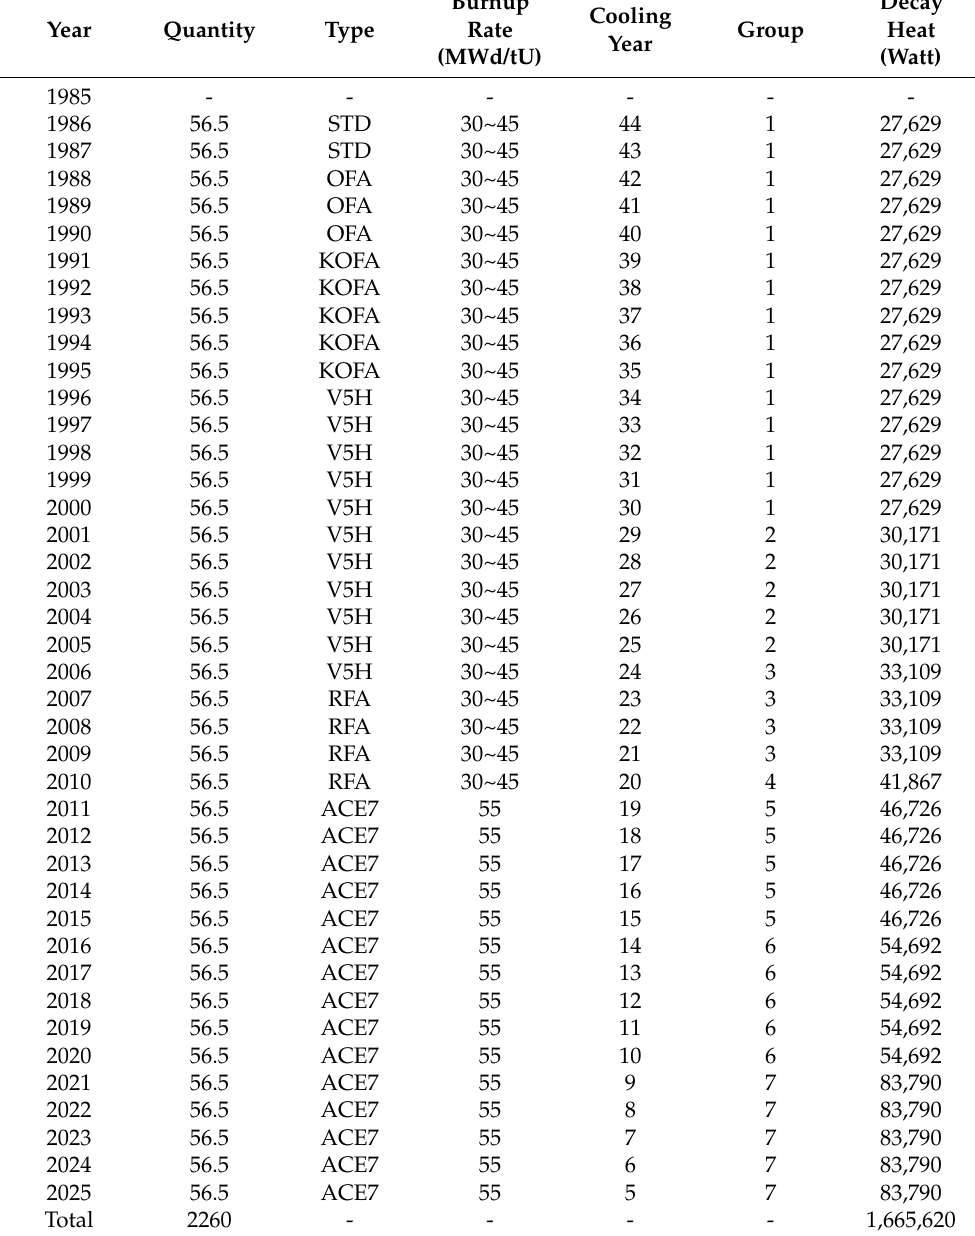
Table 8. Estimated total decay heat generation of Kori unit